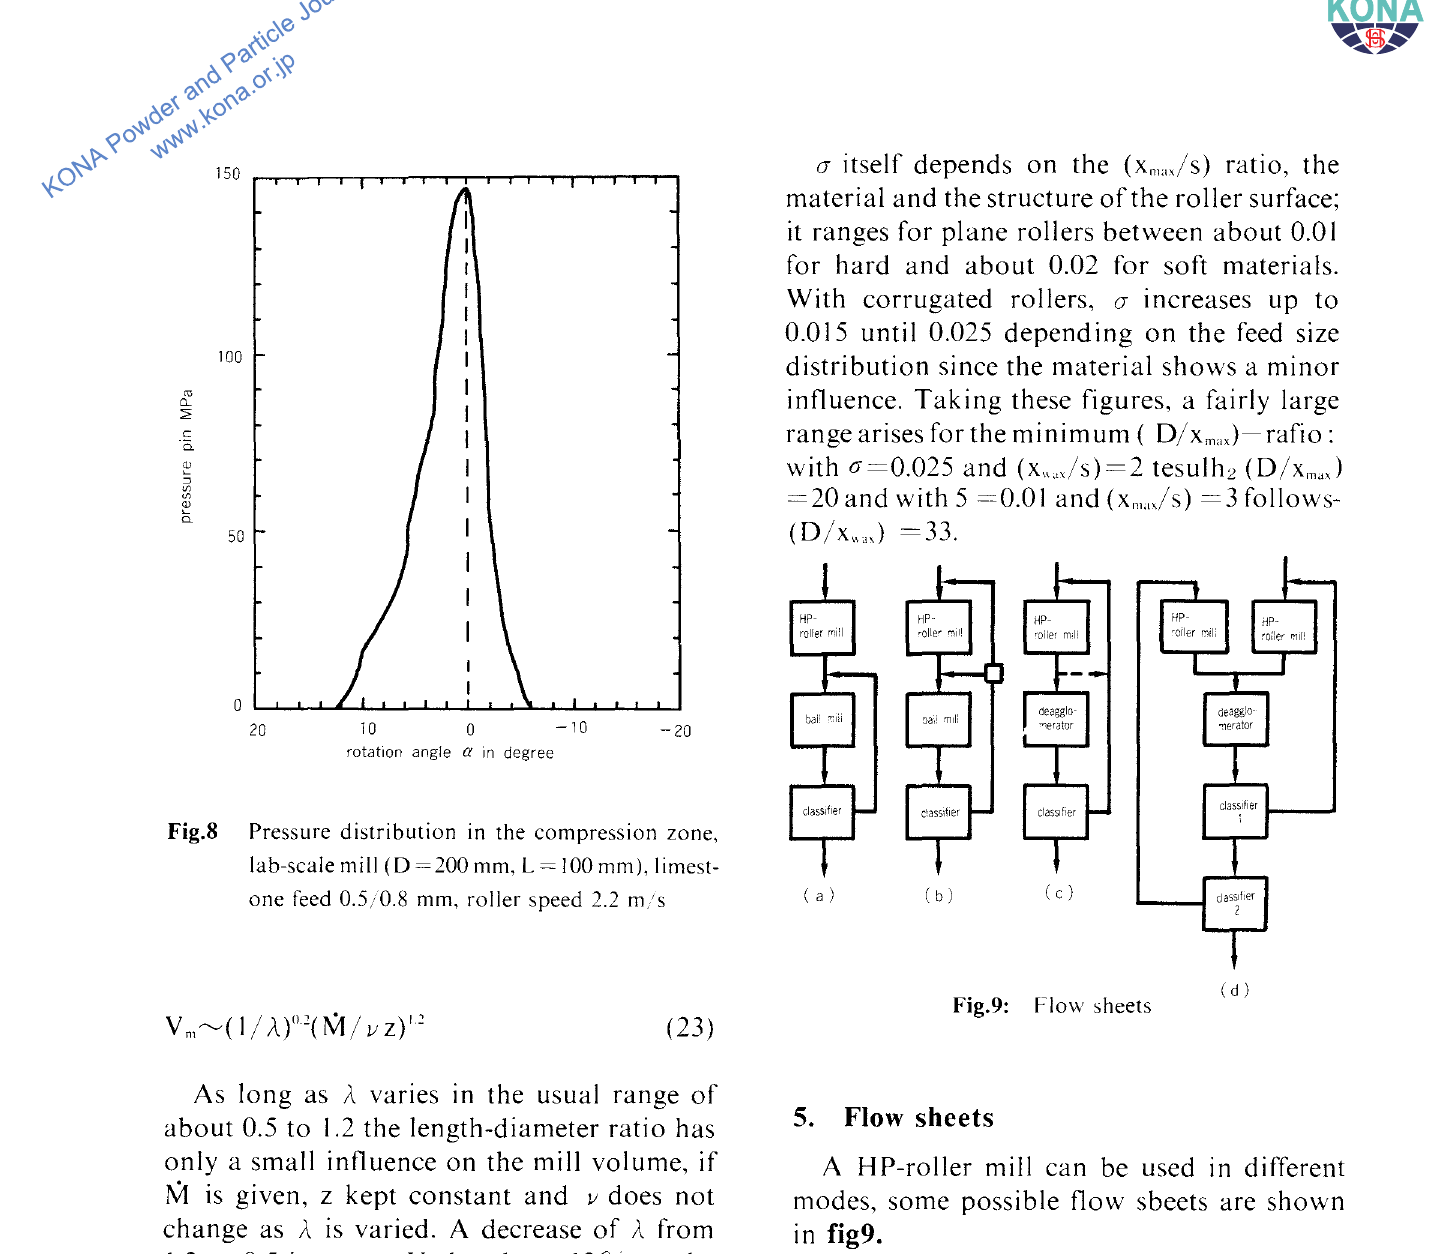
Fig.8 Pressure distribution in the compression zone, lab-scale mill (D =200 mm, L = 100 mm), limest